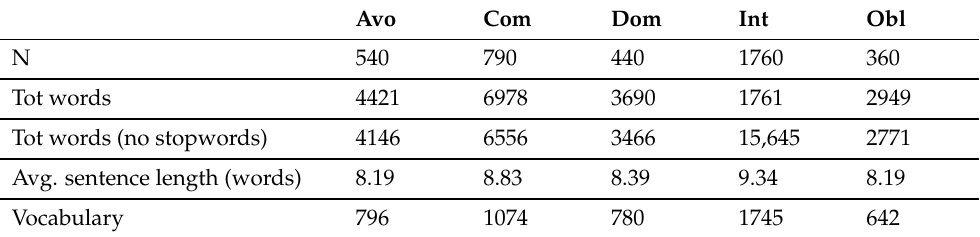
Table 5. Number, number of words, sentence length and vocabulary of each document.